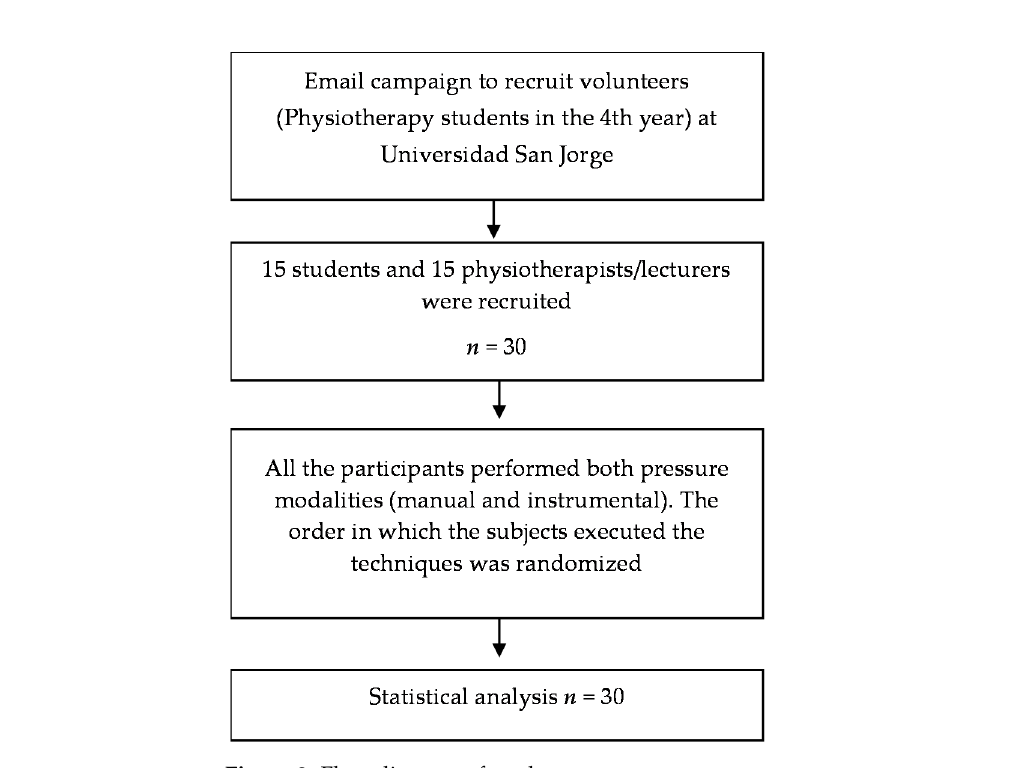
Figure 2. Flow diagram of study. Table 1. Characteristics of participants.